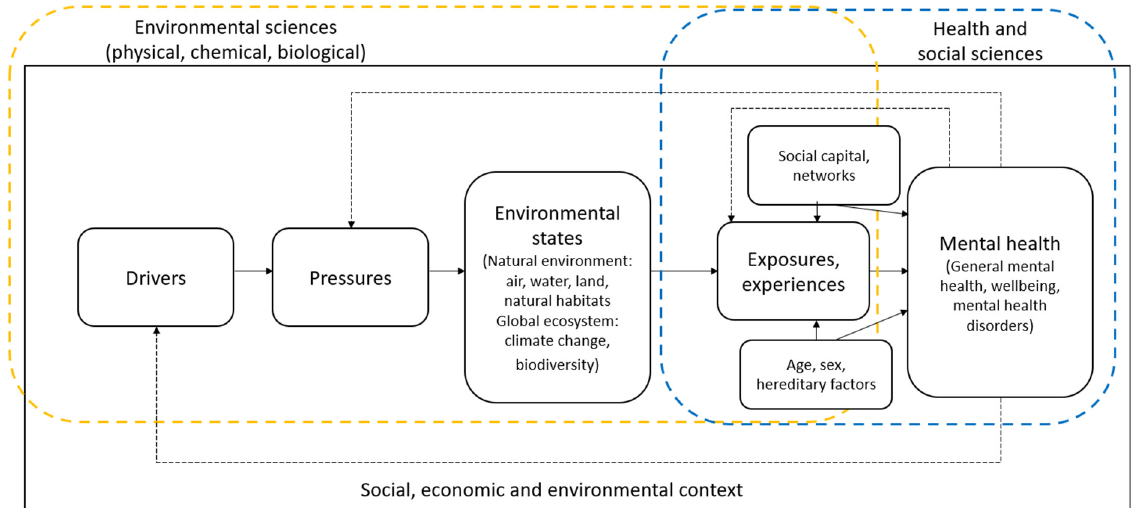
Figure 4. Conceptual model of environmental science and mental health nexus, drawing on the DPSEEA (Drivers, Pressures, State, Exposure, Effect, and Actions) framework ([27]; modified by [28,29] to include experiences) and Barton and Grant’s [25] Health Map for the local human habitat. This can be applied at the local to the global scale. Dotted lines indicate possible feedback loops, which should be considered in future work.